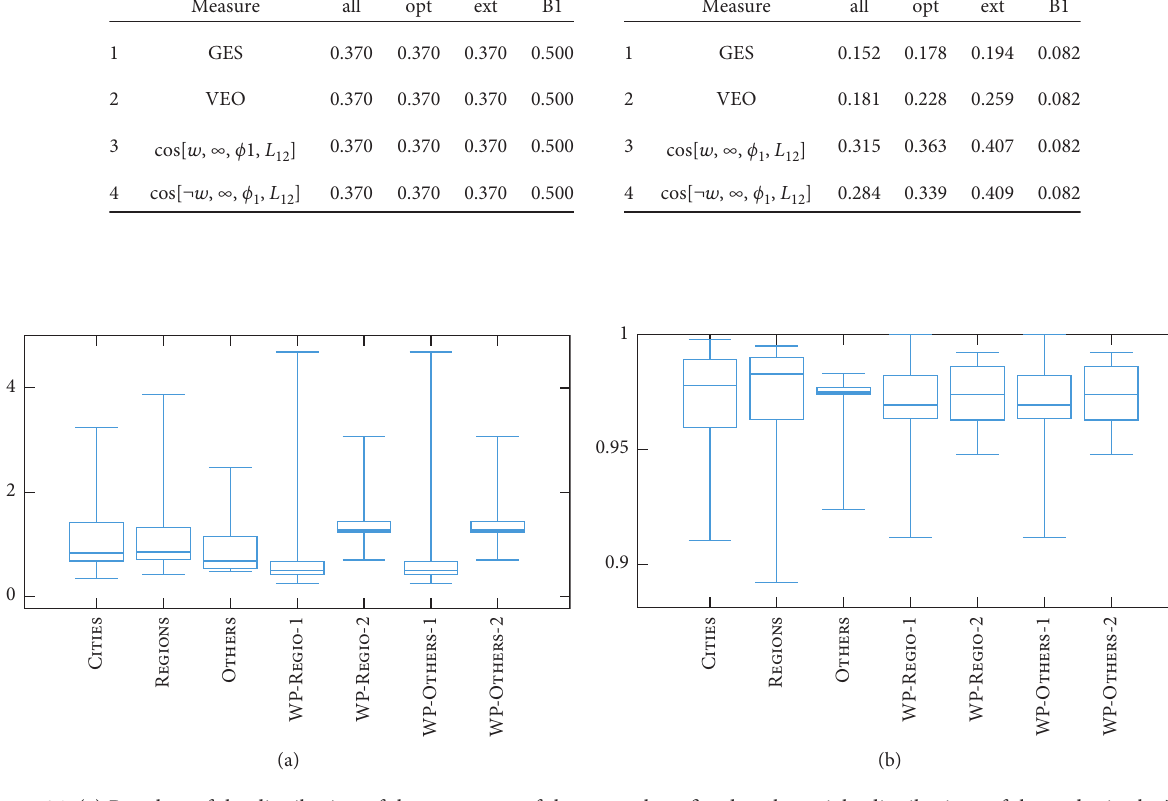
Table 9: The five most detected DDC labels for the genres C